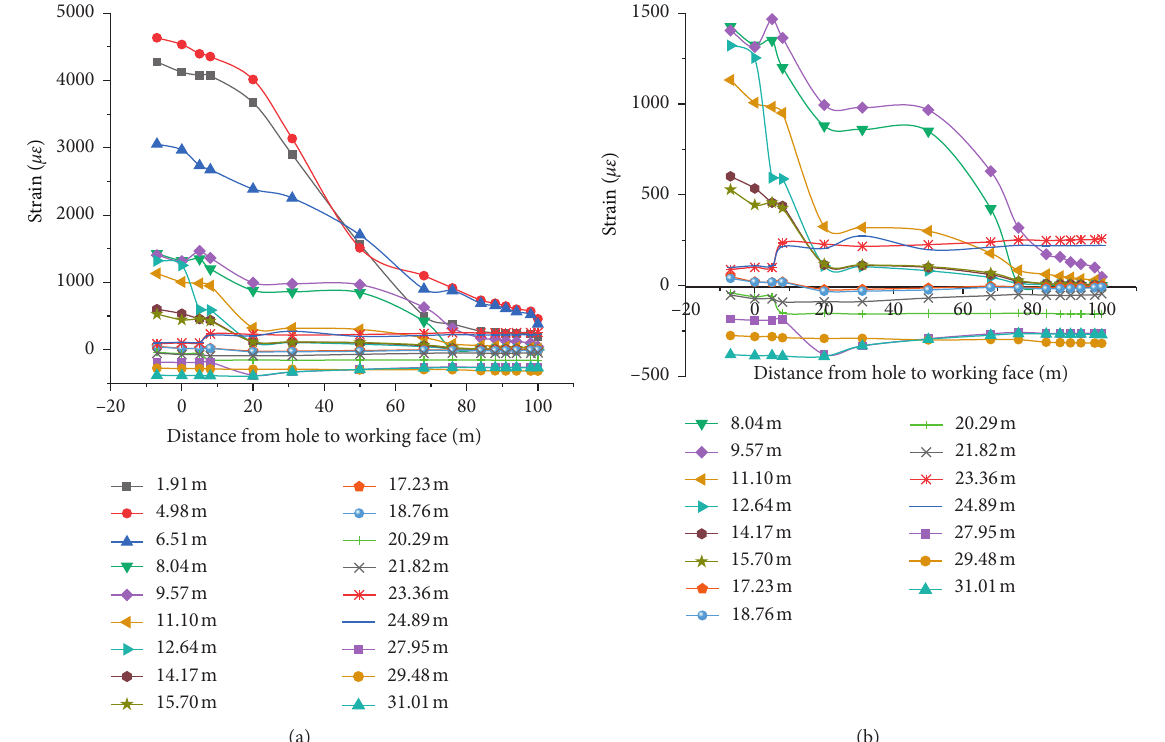
Figure 11: Strain curve of different floor vertical depths. Vertical depth was (a) 1.91–31.01 m and (b) 8.04–31.04